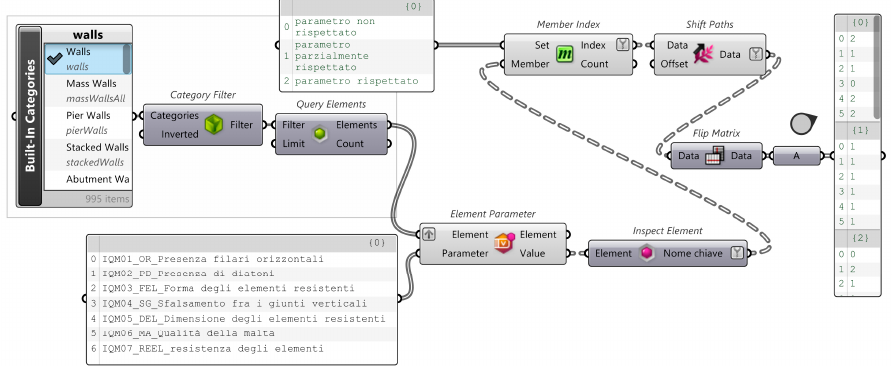
Figure 6. Part of VPL code that reads, for the selected walls, the values written by the IQM operator in the previously added IQM parameters.